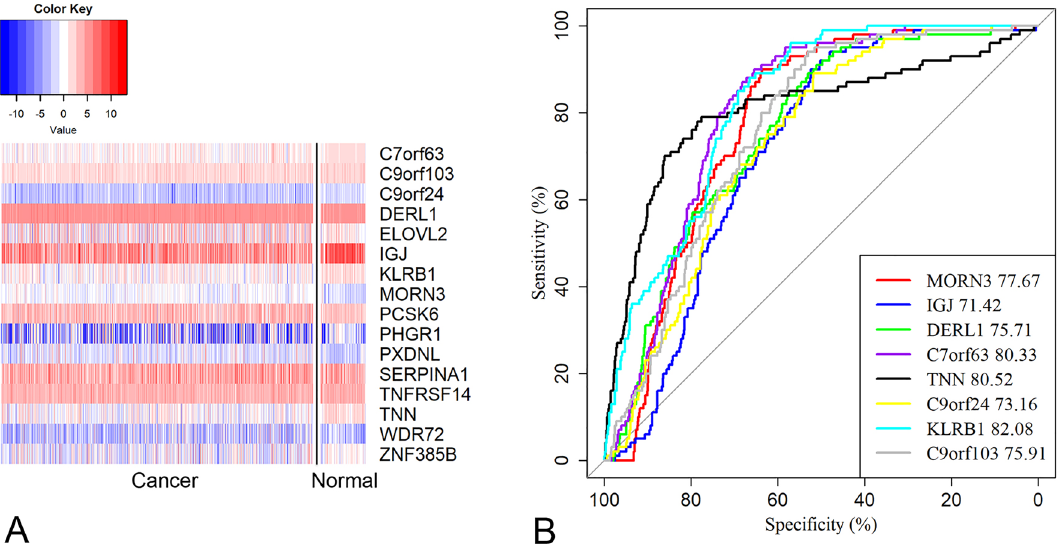
Figure 6. Gene expression analysis of prognosis-related genes. ( A ) The heatmap shows the expression differences of 16 prognosis-related genes between BRCA tissues and paired normal breast tissues. ( B ) The ROC curves for the top eight prognosis-related genes showing the highest diagnostic